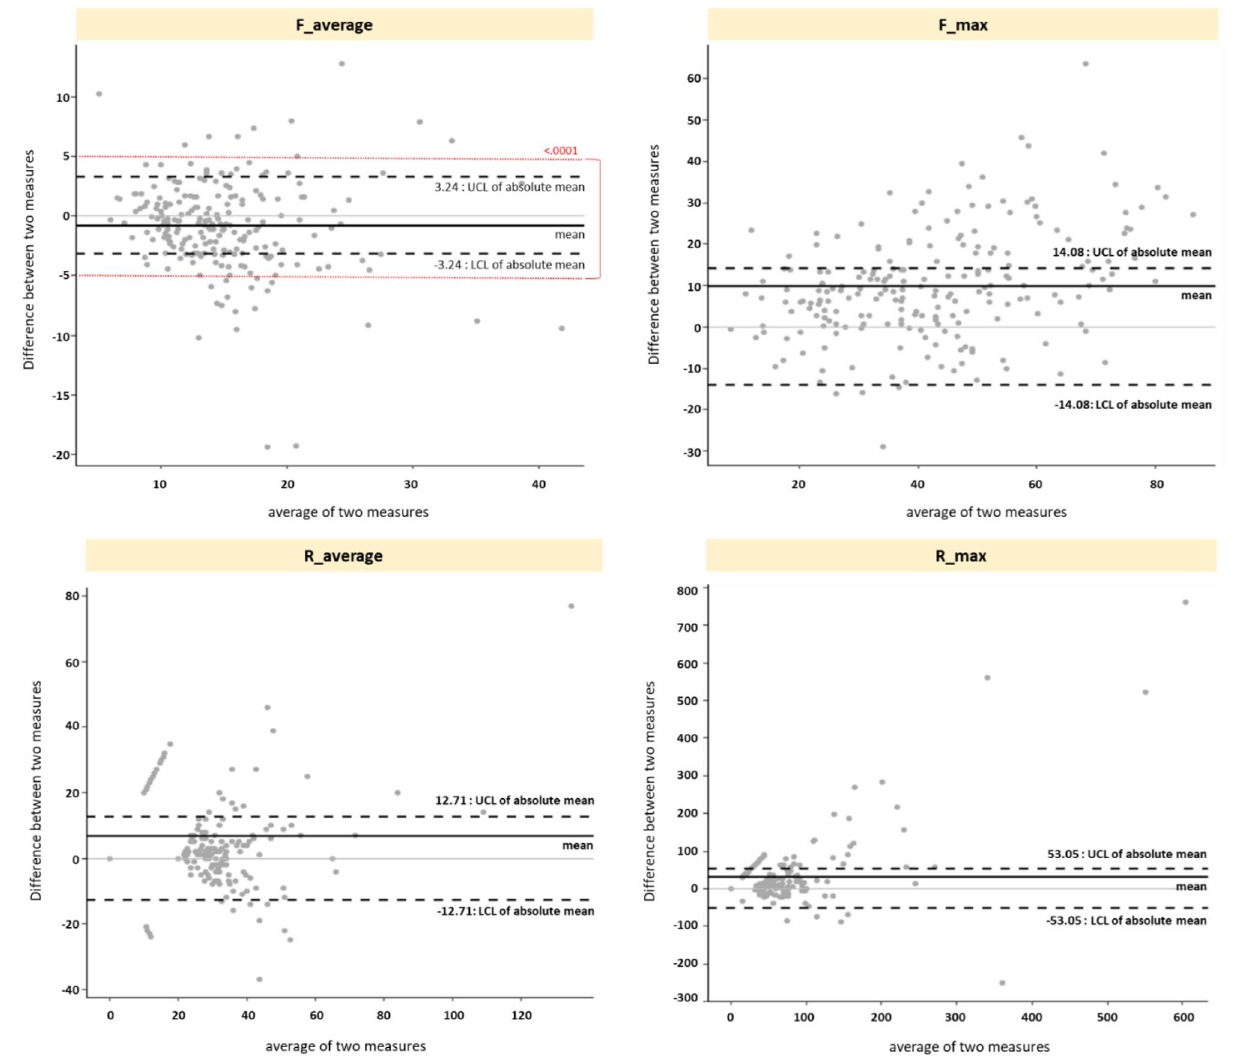
Figure 1. Agreements between the fluorescence parameters obtained from different devices (Bland–Altman plot).